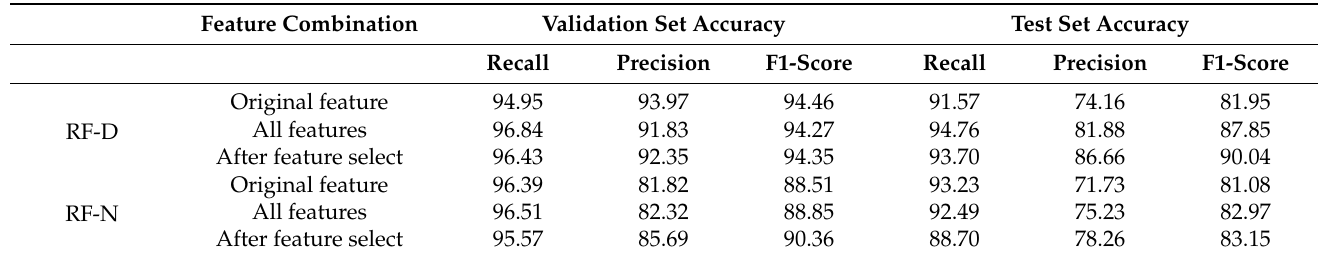
Table 5. Accuracy of RF models constructed with different feature combinations on the validation and test